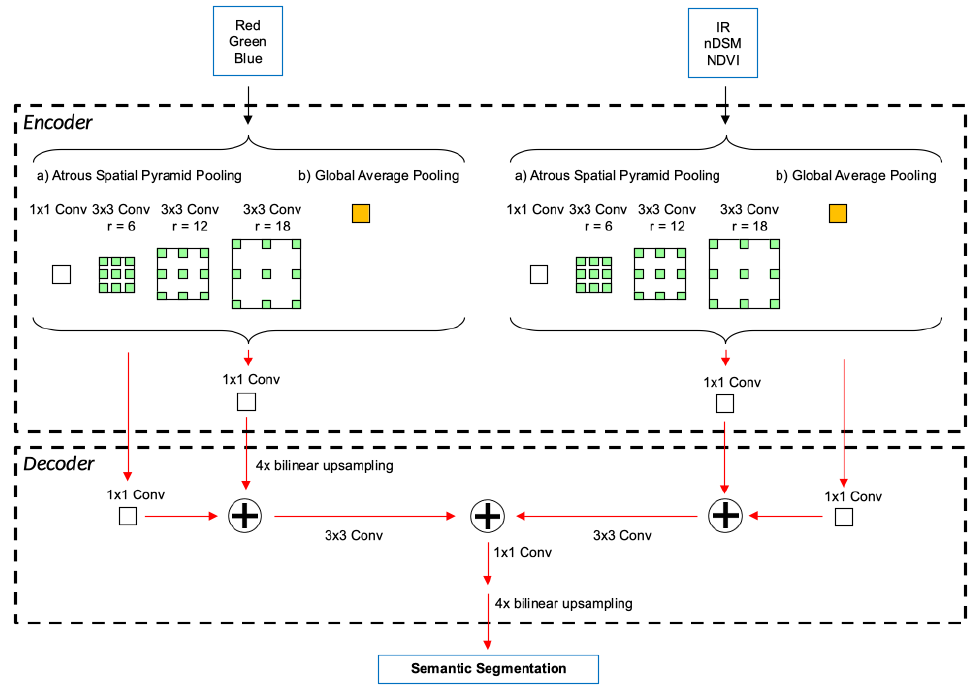
Figure 3. Dual-stream